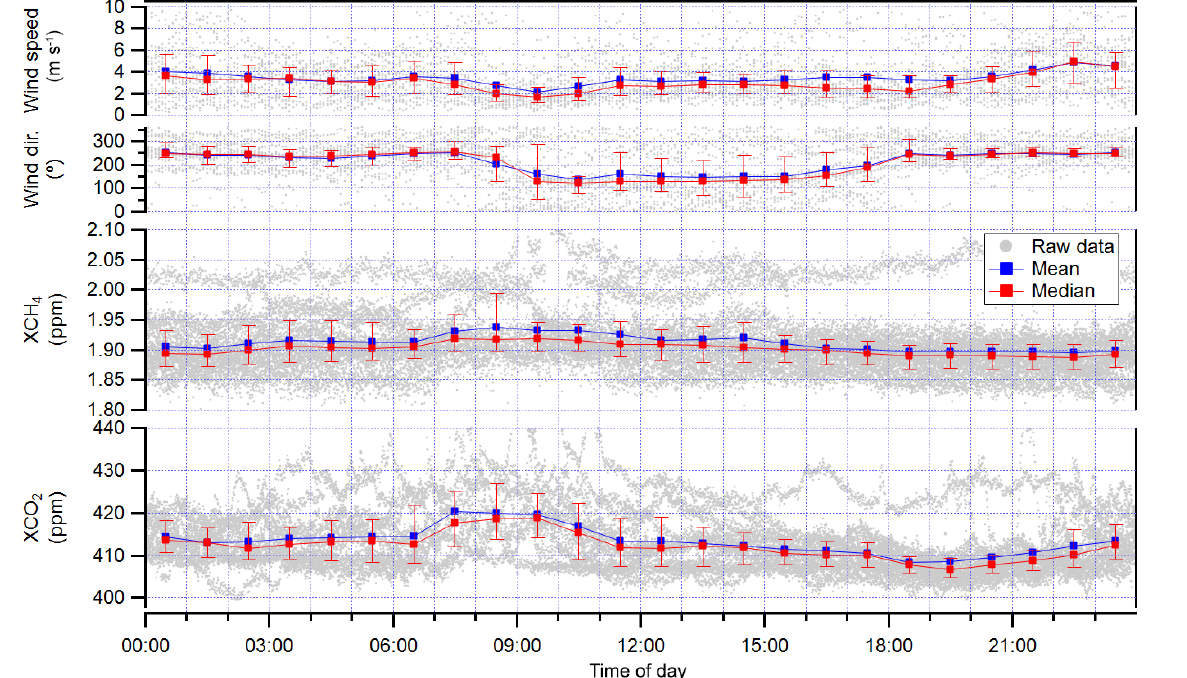
Figure 10. Diurnal cycles for wind speed, wind direction, XCH 4 , and XCO 2 . Data from each day in Fig. 5 are overplotted in grey along with the hourly mean (blue) and median (red) values. Uncertainty bars on the median values span the 75th quantile and 25th